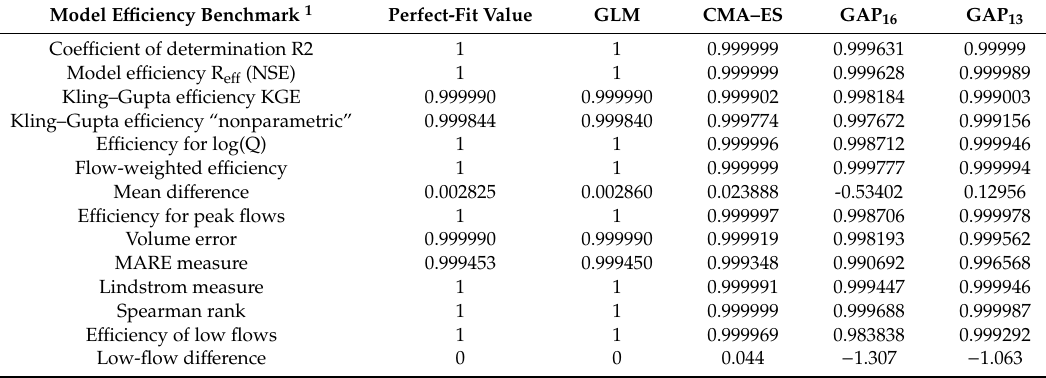
Table 4. Calibration results 1 from history matching of the synthetic model over ten years, i.e., 1 October 1981 to 31 December 1991.